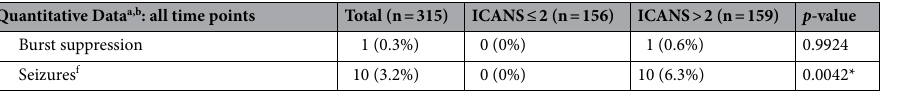
Table 1. Dataset characteristics. Patient Characteristics according ICANS grade ≤ 2 as compared to > 2 (severe ICANS). a Dataset included 135 individual subjects who received CAR-T cell therapy. b Quantitative data are shown as medians (IQR) or means (SD) and compared using Mann–Whitney U tests. c Categorical data are shown as n = counts (percent) and compared using Chi-Squared tests. The significance level was set at p < 0.05 and is indicated by *. d Demographic data (age, sex, race, and ethnicity), subtype of malignancy, and death at one-year post discharge are based on information extracted from the electronic health record. e EEG features were extracted from 15 s images manually. f Seizures were not included as an input to the model due to their direct correlation with clinical ICANS scores (if present, ICANS is an automatic 3 or